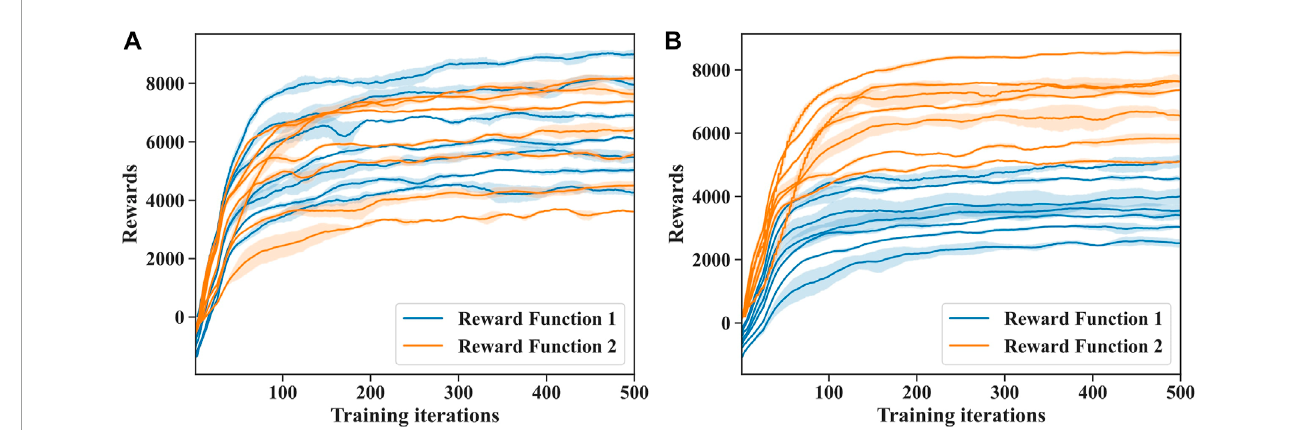
FIGURE 5 (A) Deep reinforcement learning training progress by two different reward functions for soft snake robot underwater locomotion. (B) Deep reinforcement learning training progress by two different reward functions for rigid snake robot underwater locomotion.